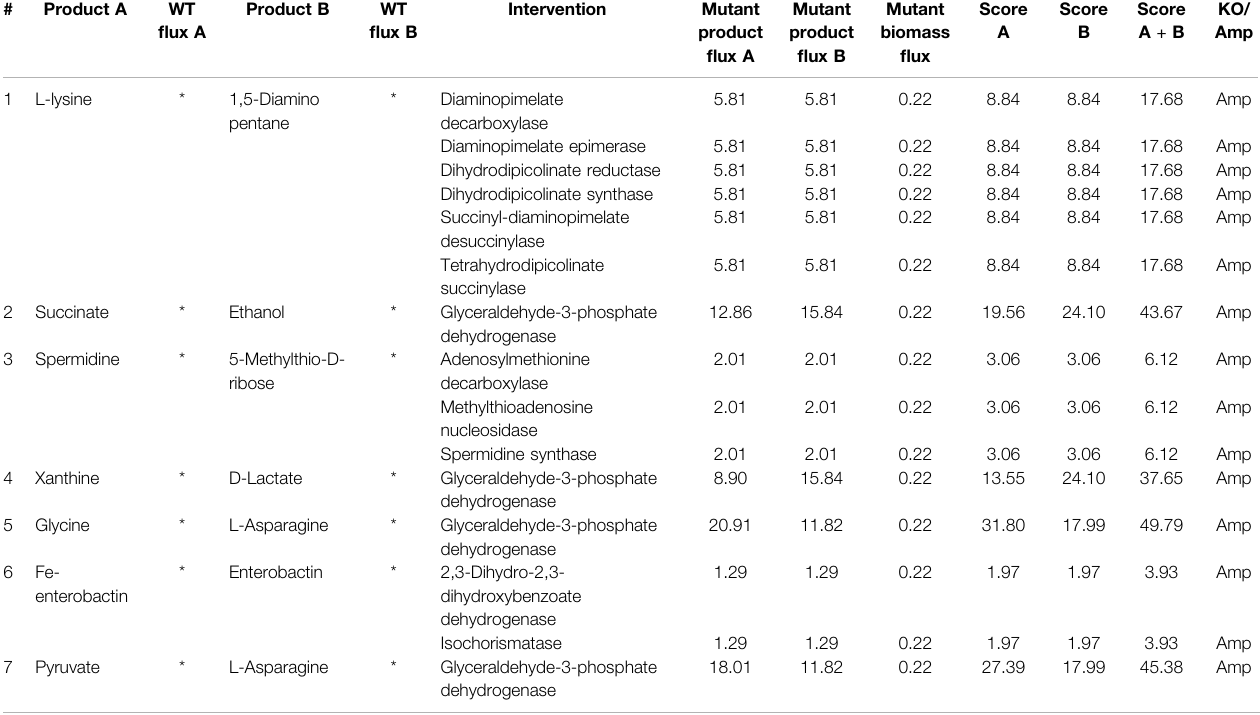
WT, wild type; *, less than 10 − 5 mmol/gDW/h.